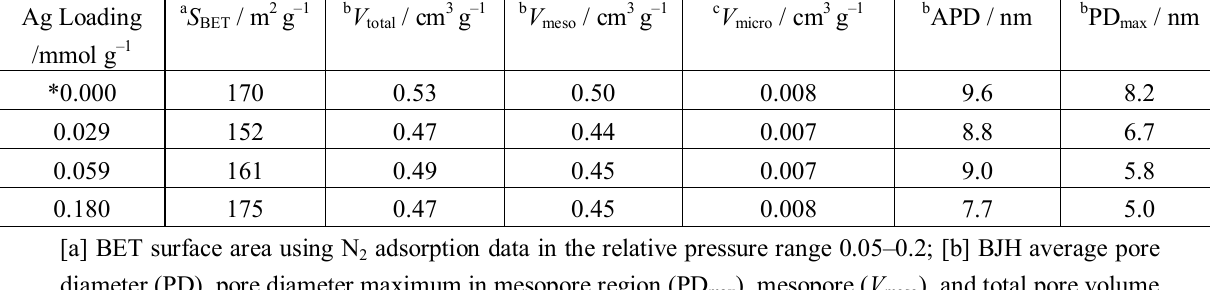
Table 1. N sorption data for MS/AgNP materials prepared at increasing Ag 2